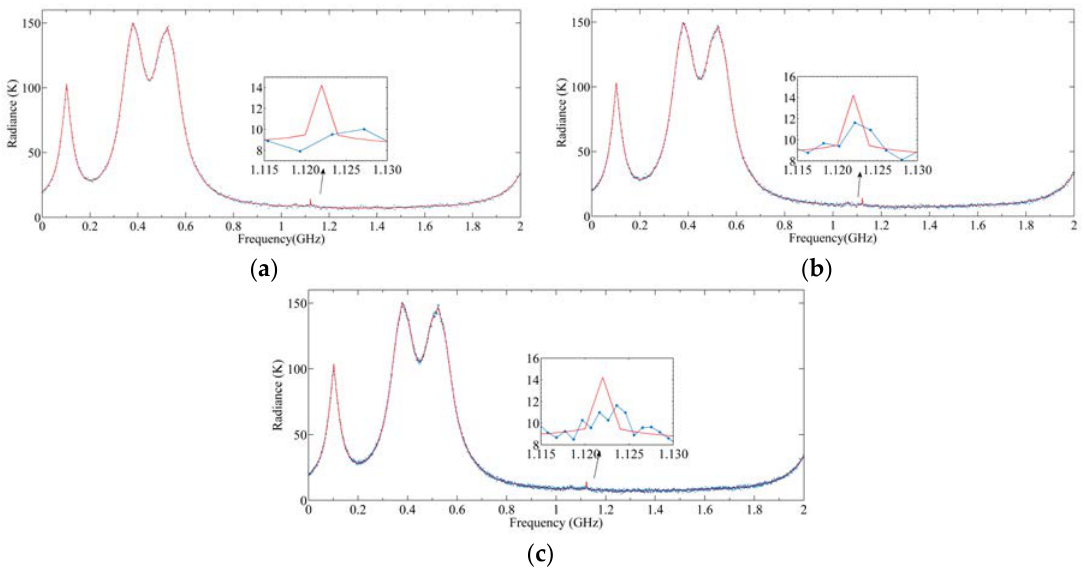
Figure 17. Output radiances under different spectrum resolutions: ( a ) 4 MHz; ( b ) 2 MHz; ( c ) 1 MHz.